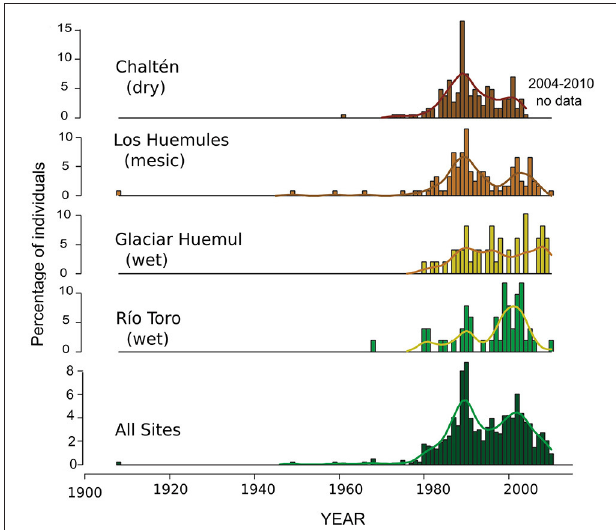
FIGURE 4 | Frequency distribution of individuals established at the upper-treeline sites. Sampling sites ordered from the driest (top) to the wettest (bottom) along El Chalten-Laguna del Desierto precipitation gradient. The regional establishment is shown at the bottom. Smoothed versions of the establishment temporal distributions estimated using a 10-year cubic spline function are also